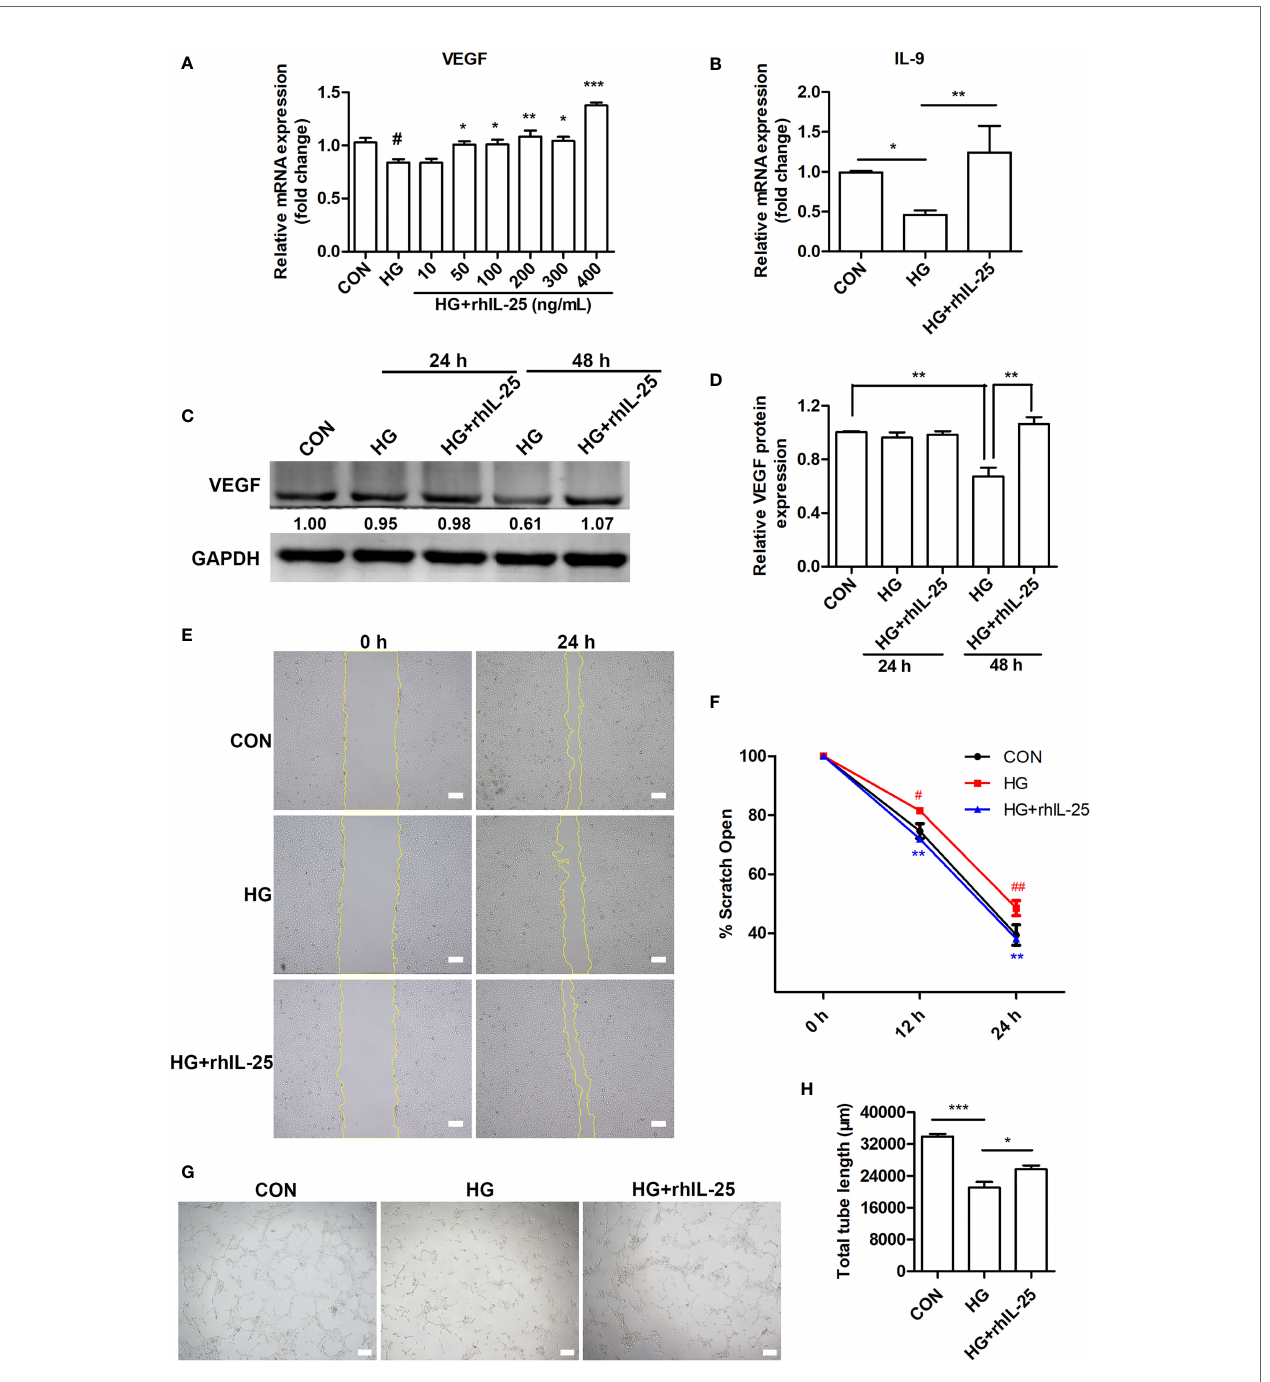
FIGURE 5 | IL-25 promotes angiogenesis and migration of HUVECs under high glucose conditions. (A) HUVECs were treated with high glucose and gradients of recombinant human IL-25 (rhIL-25) (10, 50, 100, 200, 300 and 400 ng/mL) for 48 h. Relative VEGF mRNA expression in HUVECs in increasing concentrations of recombinant human IL-25 (rhIL-25) under high glucose conditions was detected by qPCR analysis (n = 3). (B) Relative IL-9 mRNA expression in HUVECs stimulated by 400 ng/mL rhIL-25 under hyperglycemic conditions (HG + rhIL-25) (n = 3). (C) VEGF protein expression in HUVECs under HG + rhIL-25 treatment was evaluated by western blotting. (D) Quanti fi cation of VEGF protein expression in C (n = 3). (E, F) Representative images and quanti fi cation of HUVEC scratch wound migration test (n = 3). Scale bars, 200 m m. (G, H) Representative images and quanti fi cation of HUVEC tube formation assay (n = 3). Scale bars, 200 m m. * and # P < 0.05, ** and ## P < 0.01, *** P < 0.001 ( # compared with CON group, *compared with HG group). ns, no signi fi